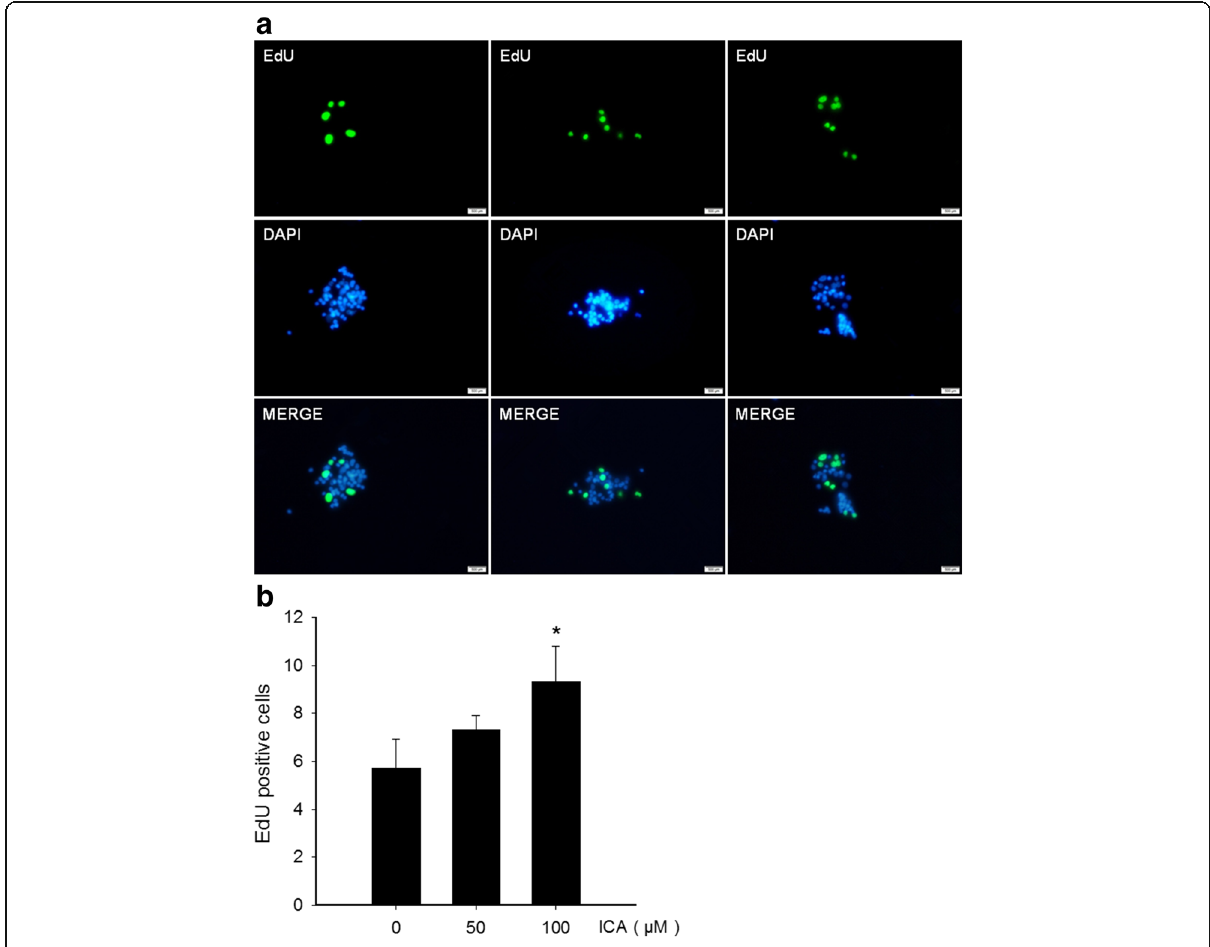
Fig. 4 Proliferating cells were examined using the EdU assay. ICA increased the EdU-positive cells. a EdU incorporation visualized by specific EdU antibody immunofluorescence. Photomicrographic images were representative of control, 50 and 100 μ M ICA-treated rat hippocampal cultures. b Quantitation of EdU-positive cells from 10 randomly selected fields per slide. Data are from three independent experiments, and the results are presented as mean ± SD of three individual experiments. * P < 0.05 vs